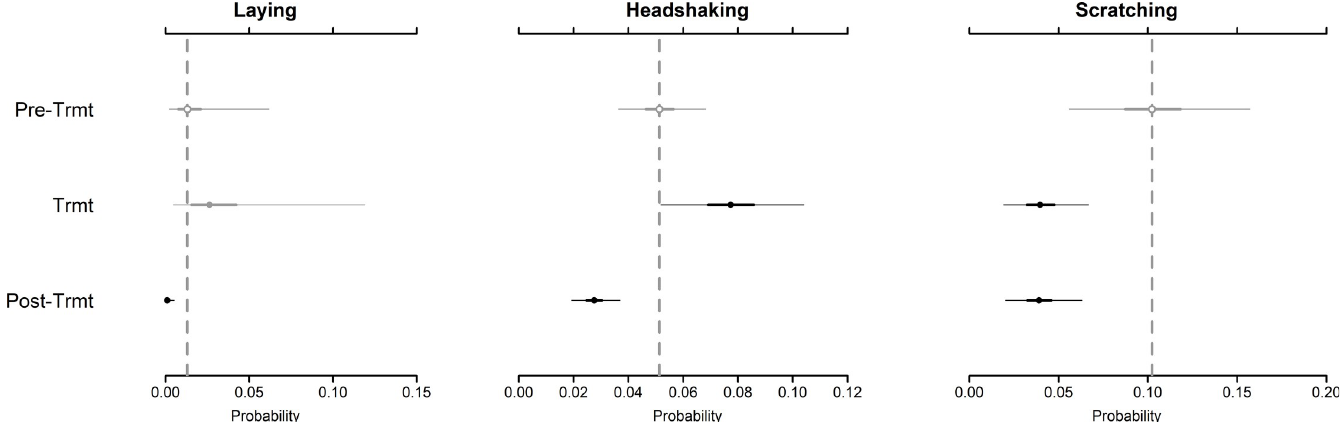
Fig 2. Estimated changes in three behaviors indicative of adverse responses to GPS collaring by scimitar-horned oryx (Oryx dammah). Predicted frequencies of each behavior are represented by point estimates (Bayesian posterior medians) and credible intervals (95% CIs—thin lines; 50% CIs—thick lines) across three treatment periods (Pre-Trmt: Pre-treatment; Trmt: Treatment; Post-Trmt: Post-treatment). Vertical dashed lines represent the posterior median for each parameter during the pre-treatment period (control). Credible intervals overlapping the pre-treatment median are colored gray (non-significant difference) or black (significant difference). Open circles indicate overlap with the 50% credible interval; closed circles indicate overlap with the 95% credible interval. Summary statistics for all parameters are provided in S1 Table.